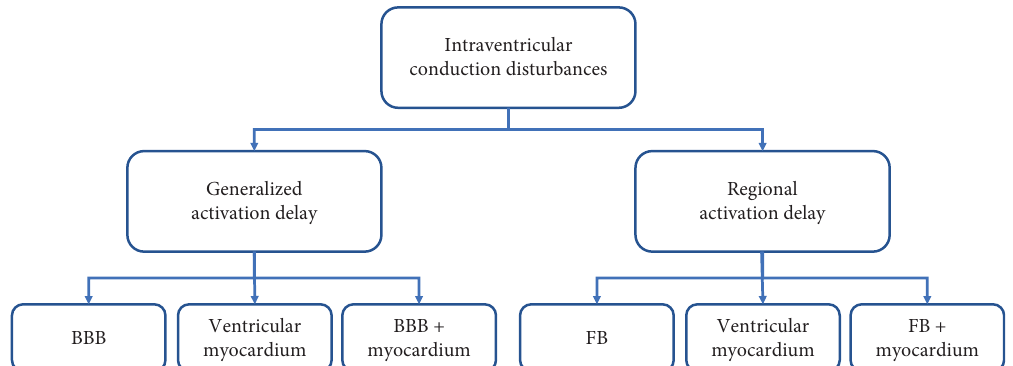
Figure 2: In the intraventricular conduction disturbances the activation of the whole ventricle or its part is delayed. In the generalized intraventricular block the delay can be caused by: (1) Te delayed onset of activation due to blocks in H-P system; (2) slowed activation propagation in the pathologically changed ventricular myocardium; (3) combination of both causes. In the regional intraventricular block the delay can be caused by: (1) Te delayed onset of activation in particular ventricular area due to blocks in fascicles, (2) slowed activation propagation in the particular ventricular region due to locally pathologically changed myocardium, (3) combination of both causes. BBB: bundle branch blocks, FB: fascicular